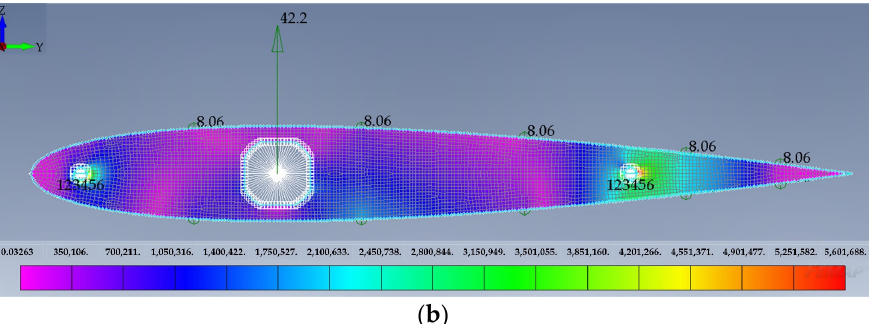
Figure 8. FEM model of rib: ( a ) Schematic of rib analysis. ( b ) VonMises stress on loaded rib (in Pascal).